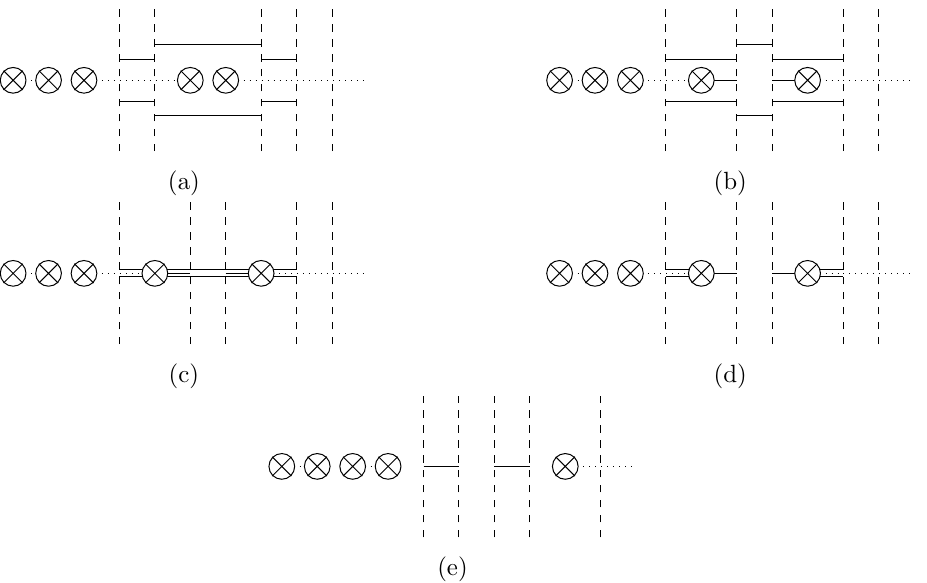
Figure 48. (cid:22) O KP transition from the closure of the subregular nilpotent orbit to the trivial (2 2 ) orbit of sp (2). (a) Higgs branch brane con(cid:12)guration of the initial system. (b) Phase transition that moves two of the half NS5-branes without brane creation/annihilation. (c) The three D3-branes are taken to the origin. They realign into a single D3-brane and then split into three new segments: the segment in the middle ends on both half NS5-branes. (d) This middle segment can acquire non zero ~x position along the directions spanned by the half NS5-branes. The limit is taken where this position goes to in(cid:12)nity, e(cid:11)ectively removing the threebrane from the system. (e) The (cid:12)xed segments of D3-branes from are annihilated via phase transitions. The resulting Higgs branch is the trivial orbit.